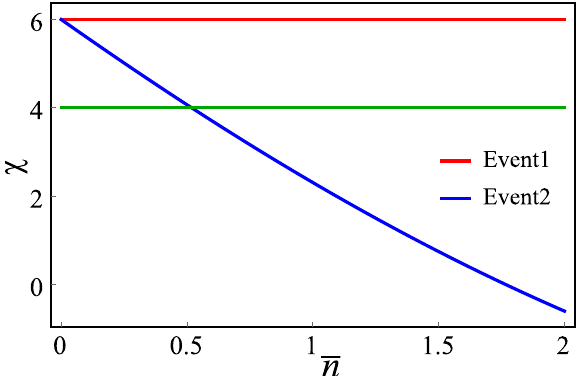
Fig. 5 Theoretical predictions of left-hand side (green line) and right-hand side (red and blue lines) of the inequality χ for a coherent light under different measurement events E 1 and E 2. We take the input being prepared in α j i with horizontal polarization as an